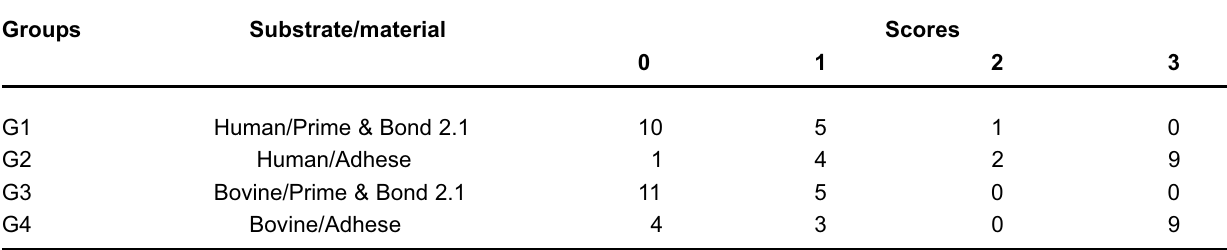
TABLE 3- Mean of microleakage and standard deviations for the interaction between the substrates